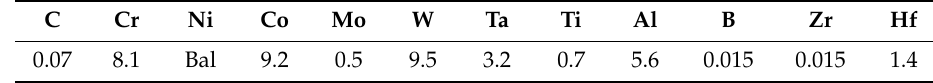
Table 2. Nominal composition of Alloy 247LC (wt.%).